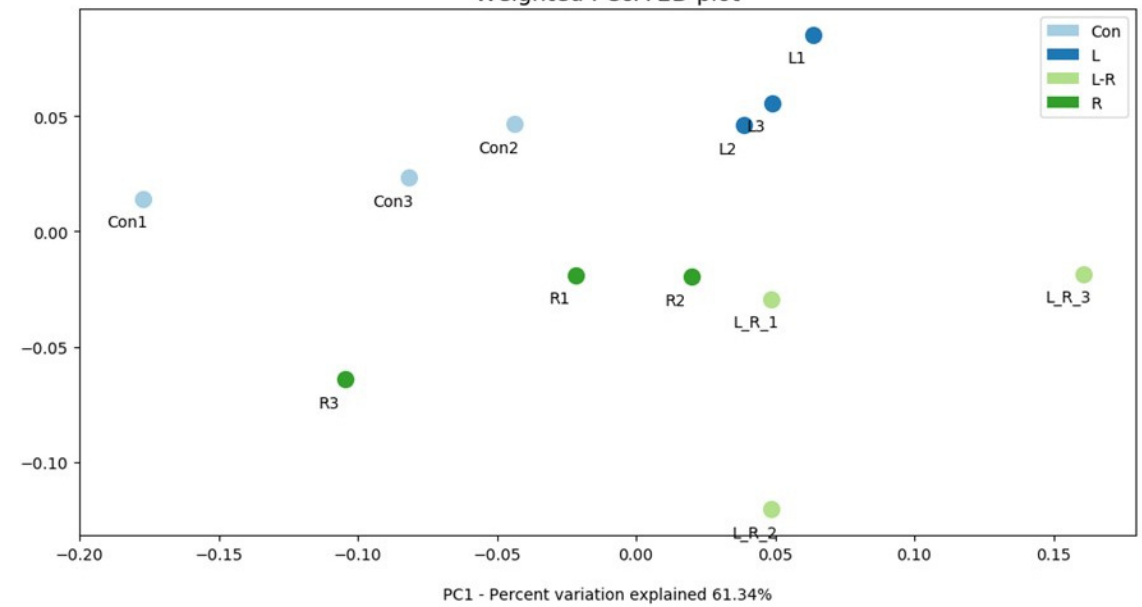
Figure 3. Advanced analysis of bacterial communities in cecum contents. PCoA of weighted UniFrac distance in the cecum contents from Con, R, L, and LR.